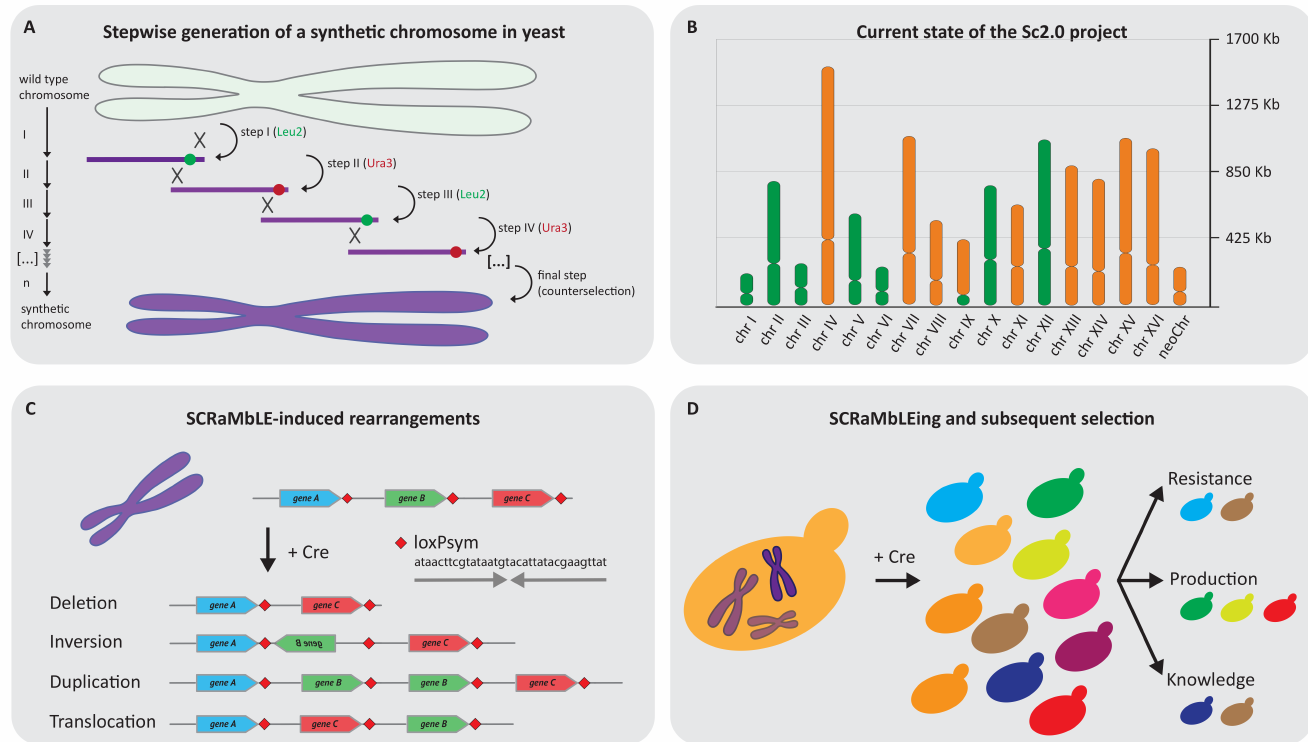
Figure 2. The Sc2.0 project and its applications. ( A ) Step by step replacement of Sc1.0 DNA by chemically synthesised DNA to generate Sc2.0. Marker swapping allows for an e ffi cient replacement of Sc1.0 DNA and gives a direct readout if Sc2.0 DNA is causing a phenotype. It is critical that the penultimate fragment contains the Ura3 marker to be able to perform counterselection with 5-fluoroorotic acid (5-FOA) to ultimately generate a marker-free strain. ( B ) The current state of the Sc2.0 project. Green indicates the finished and published chromosomes, whereas the chromosomes which are being finalised are orange. The graph also indicates the 17th nuclear chromosome which is the tRNA neochromosome containing all 275 nuclear tRNA genes. Note: for chromosome IX, only the right arm is synthesised and chromosome I is reported on the bioRxiv preprint server. ( C ) The possible outcomes of Cre recombinase on two symmetrical loxP (loxPsym) sites (deletion–inversion–duplication–translocation) indicated via gene B (green). Translocation can occur within one or between multiple synthetic chromosomes, with only the intrachromosomal event depicted here. ( D ) SCRaMbLE is an accelerated evolution tool for applied and basic sciences. Induction of Cre in synthetic yeast strains generates a highly complex population which can subsequently be screened for the desired phenotype, which can be used to answer basic questions or boost biotechnology